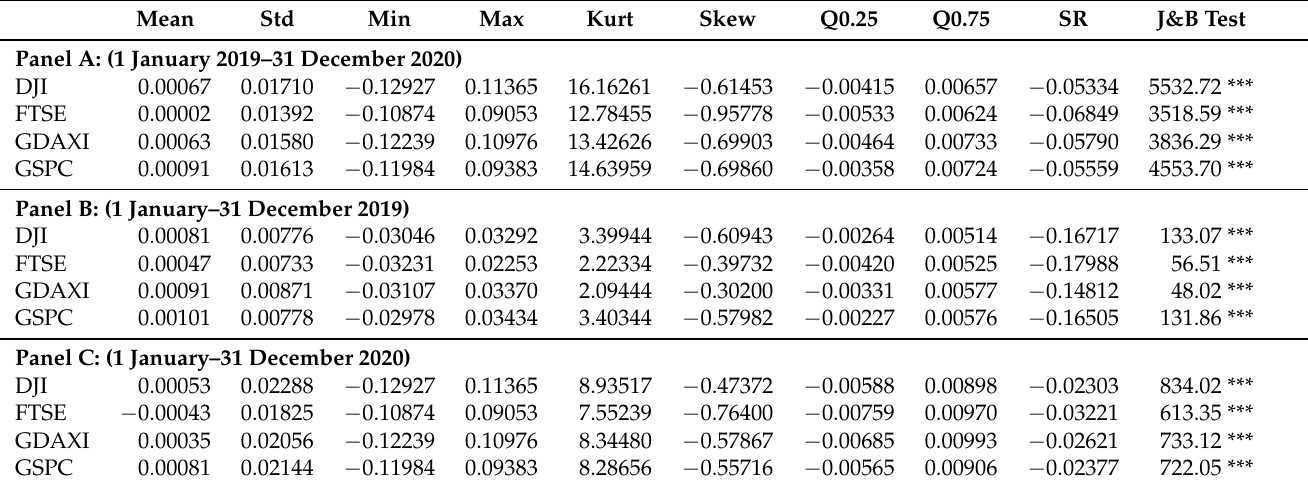
Table 3. Descriptive statistics—Stock market indices returns January 2019–December